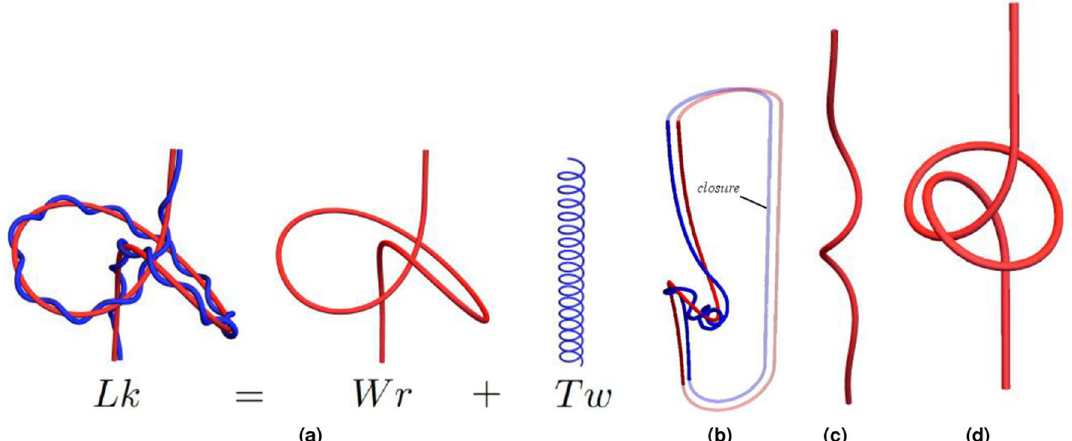
Figure 1. Illustrations of concepts discussed in the introduction. ( a ) is an illustration of the meaning of the Wr + Tw decomposition. The left figure is a ribbon structure composed of an axis curve (red) and a second curve wrapping around this axis (blue). The linking of these two curves (invariant if the ends of the ribbon are fixed) can be decomposed into the self linking of the ribbon’s axis ( Wr ) and the total rotation of the second curve around the axial direction of the first Tw . ( b ) indicates an artificial extension of the ribbon (a closure). ( c , d ) illustrate what is meant by local and non-local writhing. The curve in ( c ) coils helically at its centre; the local writhe measures this helical coiling along the curve’s length. The curve in ( d ) is knotted/self entangled, that is to say distinct sections of the curve wrap around each other. This is non-local